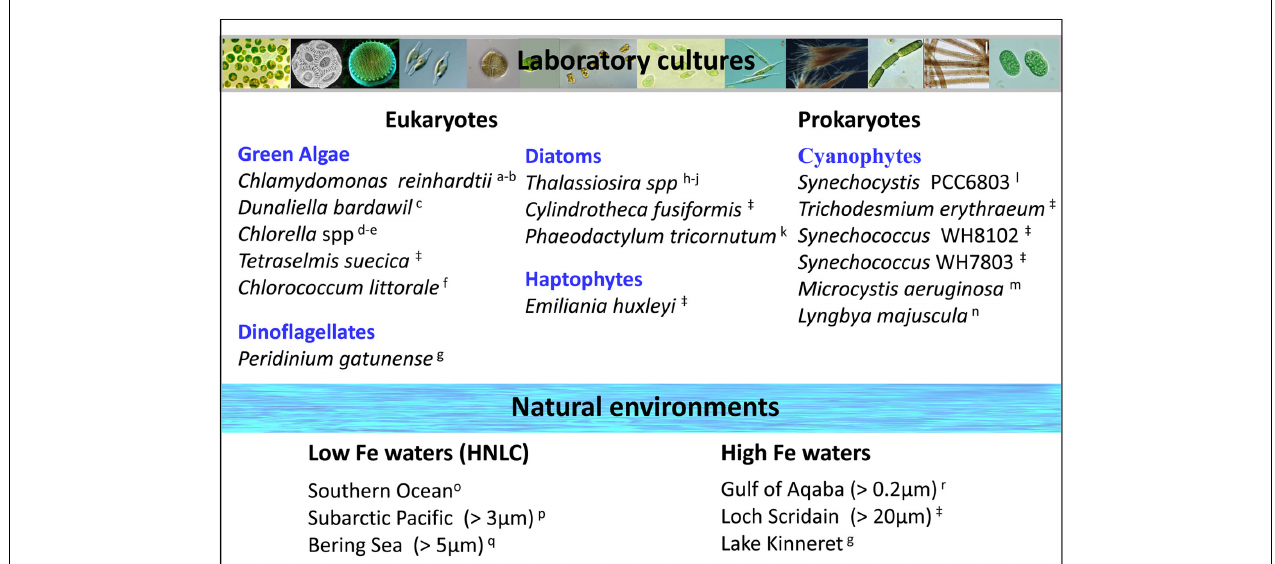
tip of the Red Sea, Loch Scridain is a sea loch located on the Atlantic coastline of the island of Mull, Scotland, and Lake Kinneret (Sea of Galilee) is a fresh water lake in the north of Israel. References: a Eckhardt and Buckhout (1998), b Weger (1999), c Keshtacher et al. (1999), d Allnutt and Bonner (1987), e Middlemiss et al. (2001), f Sasaki et al. (1998), g Shaked et al. (2002), h Shaked et al. (2005), i Jones and Morel (1988), j Maldonado and Price (2001), k Soria-Dengg and Horstmann (1995), l Kranzler et al. (2011), m Fujii et al. (2010), n Rose et al. (2005), o Maldonado et al. (2005), p Maldonado and Price (1999), q Shaked et al. (2004), r Lis and Shaked (2009), ‡ Lis and Shaked, in